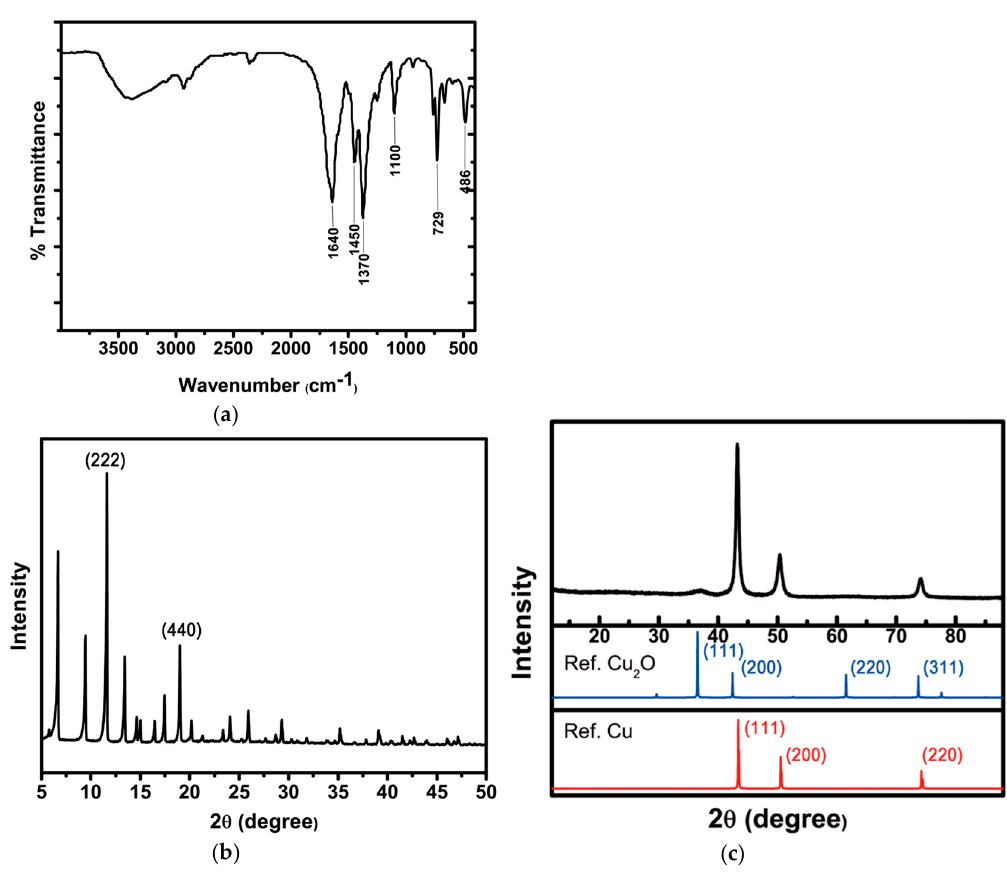
Figure 2. ( a ) FT-IR spectrum of Cu(II)-MOF; X-ray diffraction patterns of ( b ) Cu(II)-MOF and ( c ) Cu@Cu 2 O core-shell nanocatalyst.